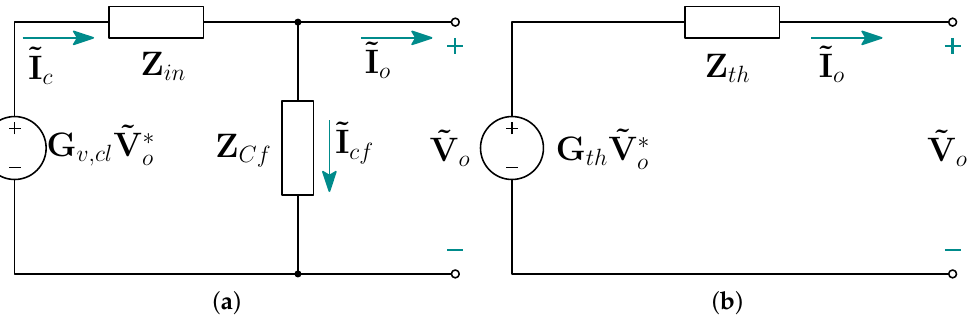
Figure 3. Equivalent circuits of the voltage controlled MMC. ( a ) MMC + capacitor bank; ( b ) Thévenin- equivalent